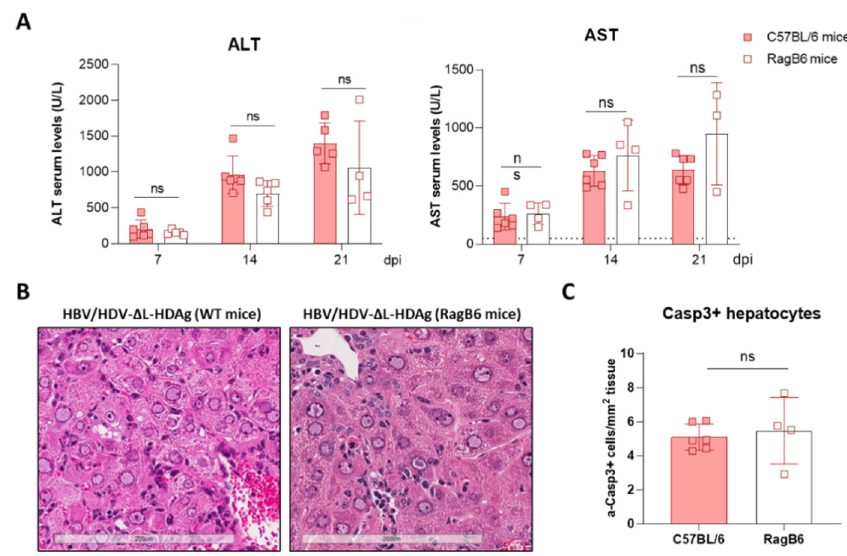
Figure 7. The liver damage triggered by the HDV mutant expressing only S-HDAg is independent of B and T lymphocytes and Natural Killer T (NKT) cells . Eight-week-old WT ( n = 4) and RagB6 mice ( n = 4) received 5 × 10 10 vg of AAV-HDV- Δ L-HDAg and 5 × 10 10 vg AAV-HBV. ( A ) Transaminase levels were analyzed at 7-, 14- and 21-dpi. Individual data points and mean values ± standard deviation are plotted; no significant differences were observed between WT and RagB6 mice injected with AAV-HBV/HDV- Δ L-HDAg by performing a two-way ANOVA and Bonferroni multiple-comparison test . ( B ) Examination of liver sections by H&E showed no histological differences between WT and RagB6 mice at 21 dpi. Scale bar: 200 µm. ( C ) Liver sections of WT and RagB6 mice receiving AAV-HDV- Δ L-HDAg sacrificed at 21 dpi were analyzed by IHC for activated Caspase 3. Mann–Whitney test did not reveal significant differences. ns: no significant.